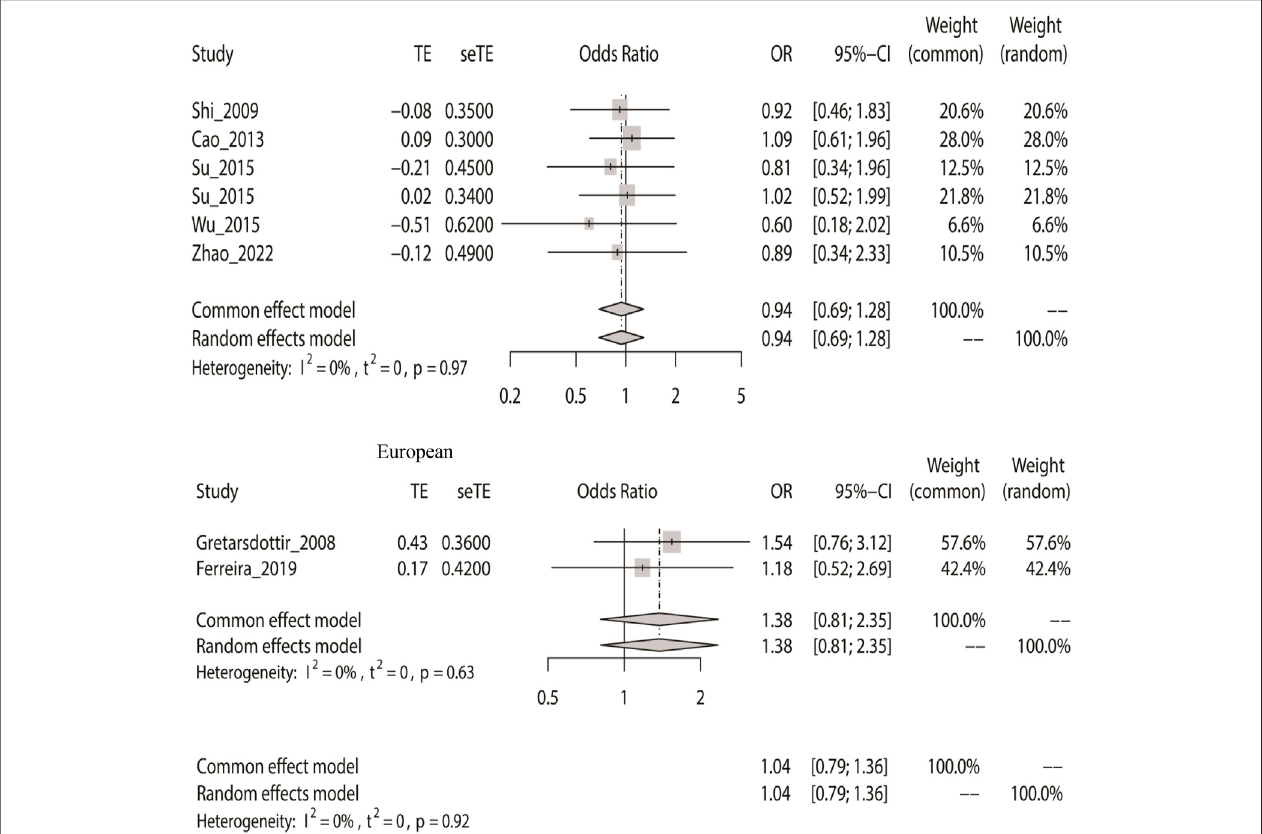
FIGURE 3 | Fixed-effect meta-analysis of the recessive model for rs2200733 and rs6843082 in the Asian, non-Asian, and pooled populations.